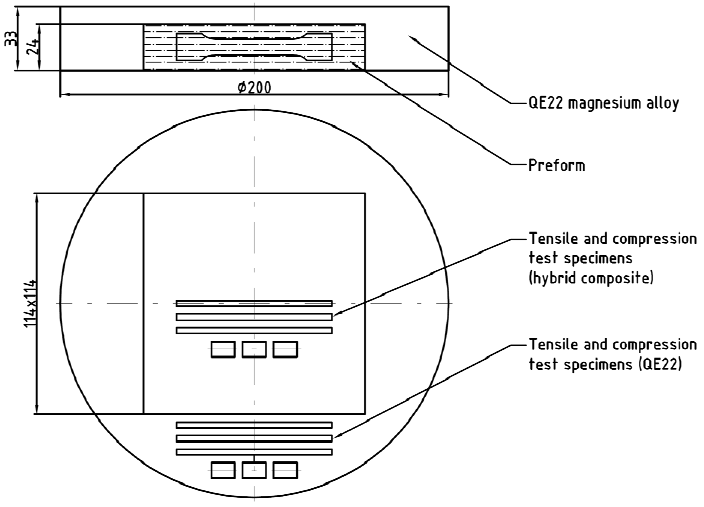
Figure 1. Sample positions in the casting.